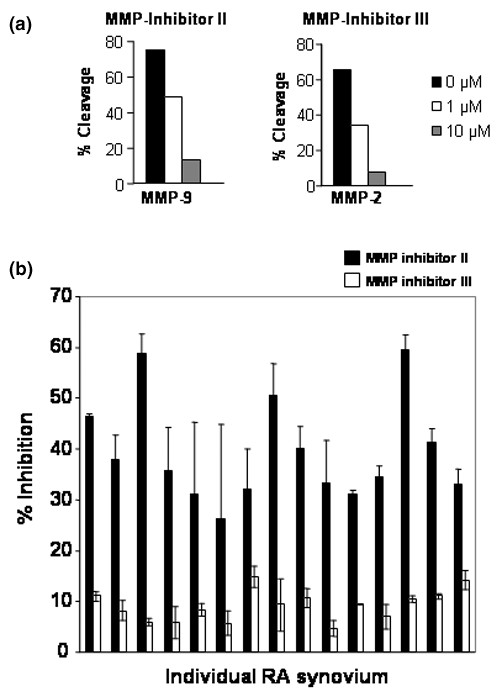
Effect of hydroxamate-based inhibitors on arthritic synovial fluids. (a) Detection of the inhibitory effect of the matrix metalloproteinase (MMP) inhibitors (inhibitor II and inhibitor III) at different doses by fluorescent-activated substrate conversion using recombinant human MMP-2 and MMP-9. Briefly, recombinant MMP-2 and MMP-9 were incubated with microspheres coated with fluorescein isothiocyanate-labelled polypeptides (derived from denatured collagen) at 37°C. The percentage of cleavage, measured by the loss of fluorescence, was measured by flow cytometry using standard optics for fluorescein (using a 525 nm bandpass filter). (b) Effect of the hydroxamate inhibitors (used at 10 μM) on rheumatoid arthritis (RA) synovial fluids. Each bar represents one sample. The results were obtained using duplicates and are representative of two independent experiments. Error bars represent the mean ± standard error of the mean.